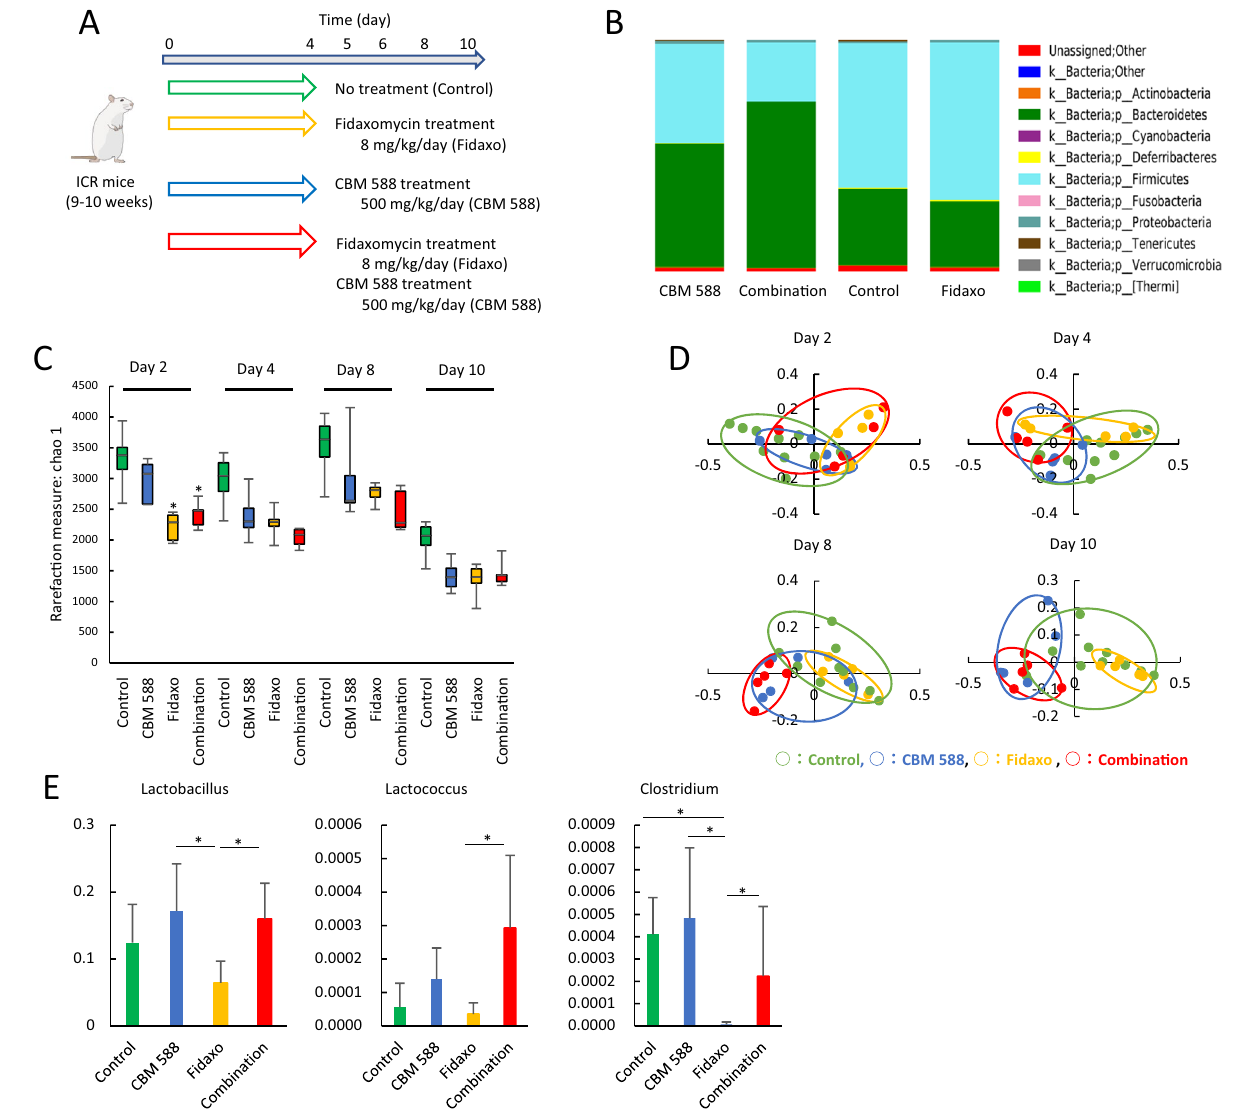
Figure 2. C. butyricum modulated the gut microbiome composition under fidaxomicin treatment and increased Lactobacillus spp. and Lactococcus spp. ( A ) Experimental design for gut microbiome analysis with 9- to 10-week-old ICR Swiss mice. ( B ) Bacterial compositions in different experimental groups at the phylum level. All values are mean (n = 5). ( C ) Comparison of the Shannon index of different groups. The box and whiskers represent the smallest and largest values, with the median in the center of each box (n = 5). ( D ) Principal Coordinate Analysis (PCoA) based on weighted Unifrac distances among CBM 588 monotherapy group (CBM 588), fidaxomicin monotherapy group (Fidaxo), and combination group (Combination). ( E ) Effect of fidaxomicin and/or CBM 588 administration on relative species abundance (≥ 0.001%) in the fecal samples. After quality filtering steps, three species ( Lactobacillus spp., Lactococcus spp., and Clostridium spp.) were considered to have significantly higher relative abundance (%) in the combination group, compared with the fidaxomicin administration group at day 8. Data represent the mean values of relative abundances ± SD (n =